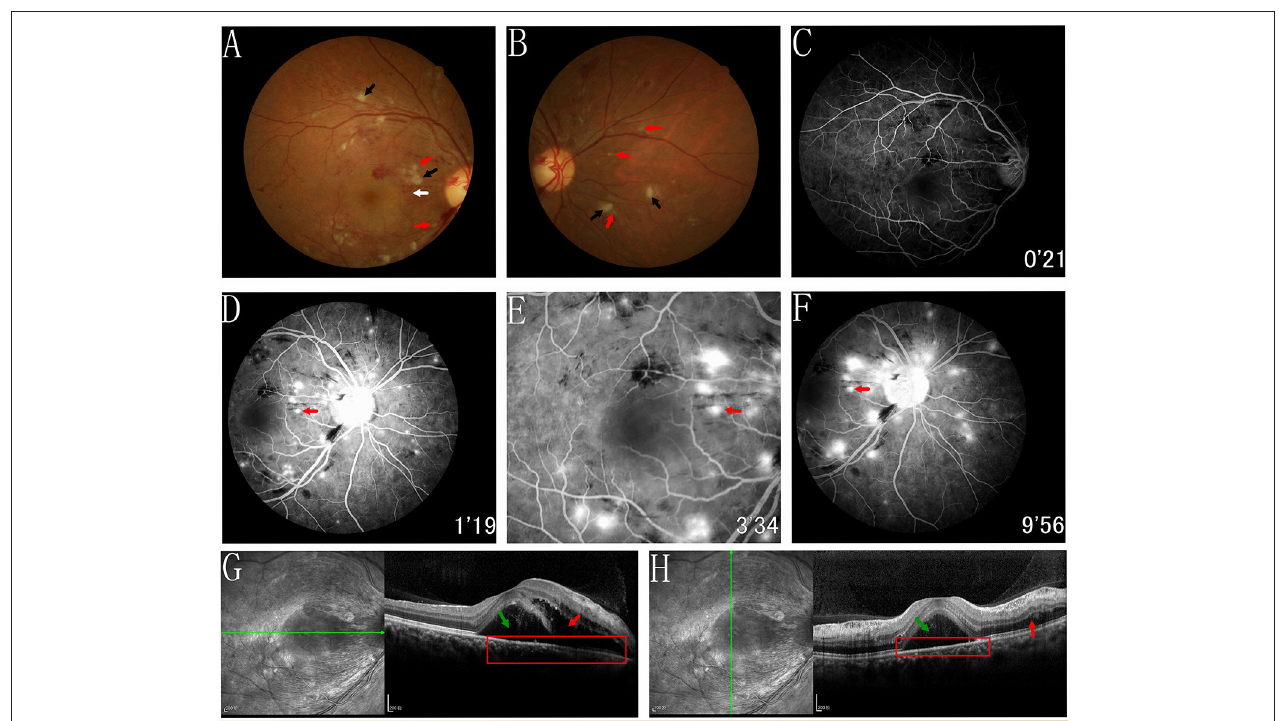
FIGURE 1 | Fundus photograph, FFA and SD-OCT of the right eye. (A,B) Funduscopic examination revealed retinal edema, intraretinal hemorrhage, elschnig spots (white arrow and red arrows), hard exudates and cotton-wool spots (black arrows) in right eye. (C) FFA showed the delayed choroidal filling regarding areas of capillary nonperfusion. (C–F) FFA showed multifocal sites of patchy hyperfluorescence in the early phase, with leakage during the entire imaging process describing elschnig spots, and blockage from the cotton wool spots. (G,H) SD-OCT showed the IRF (red arrows), SRD (green arrows) with multilayered hyperreflective lesions